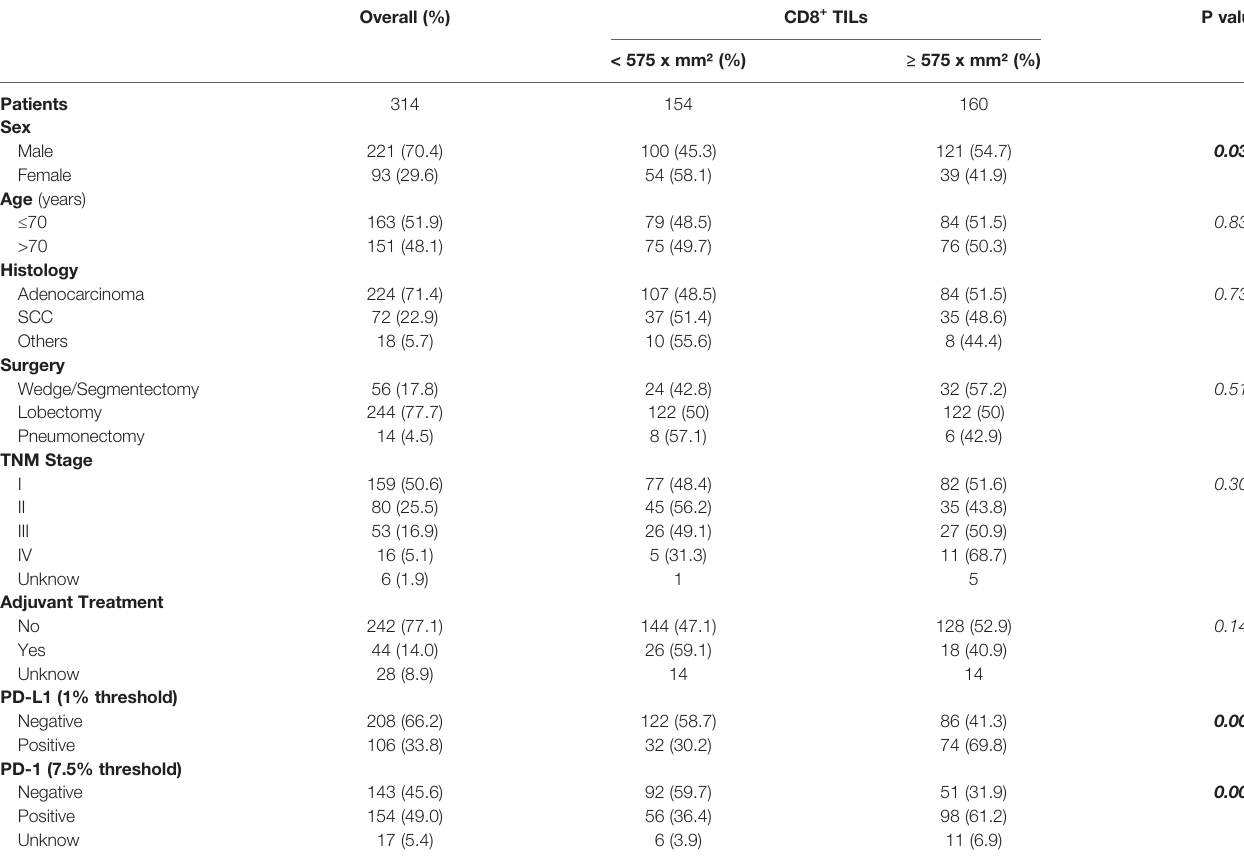
TABLE 1 | CD8 + TILs in 314 NSCLC in relation to clinicopathologic